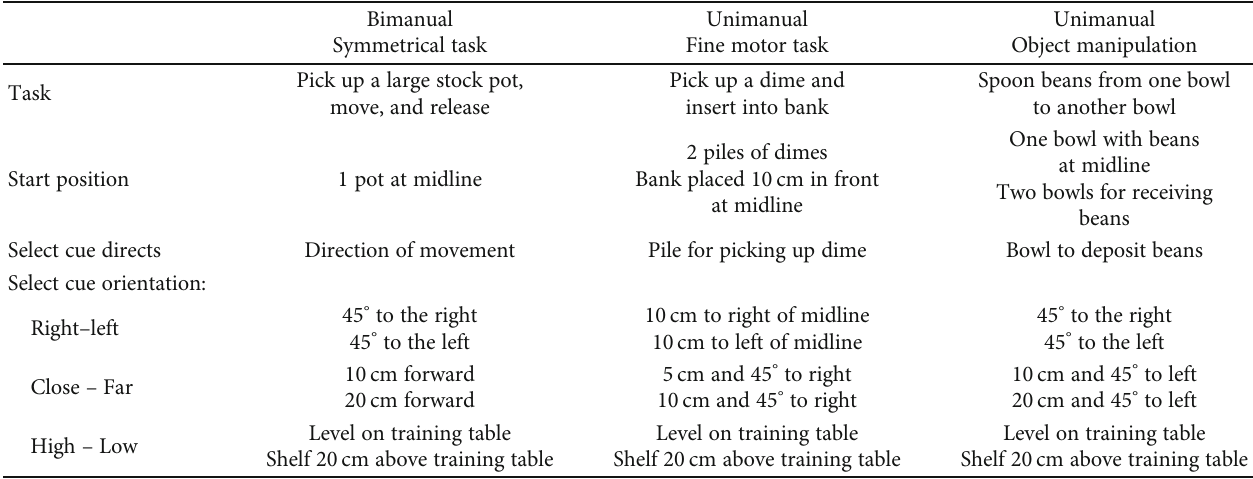
Table 2: Example of action selection cues during